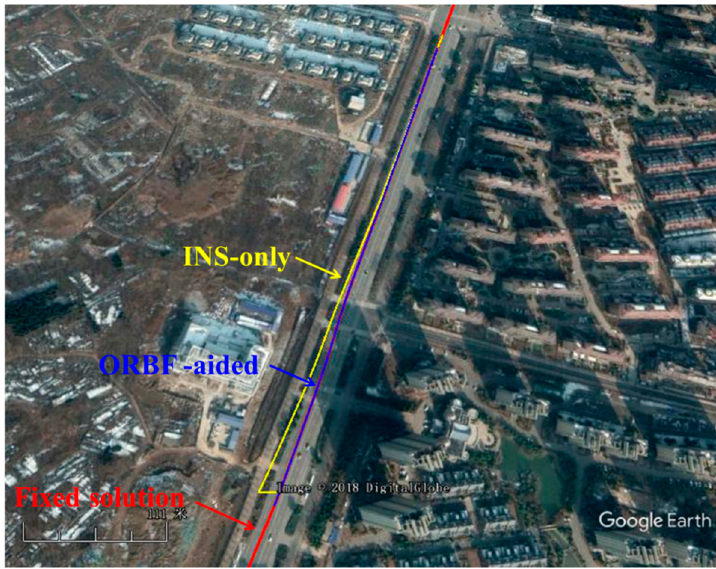
Figure 20. Ground track with three strategies during GPS/BDS outage.